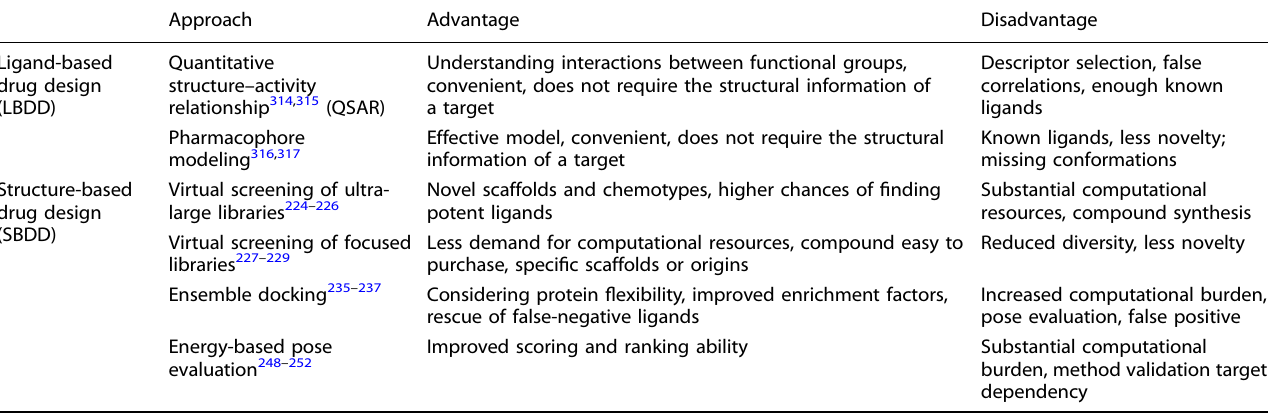
Table 6. Comparison of the advantages and disadvantages of various computer-aided drug design approaches